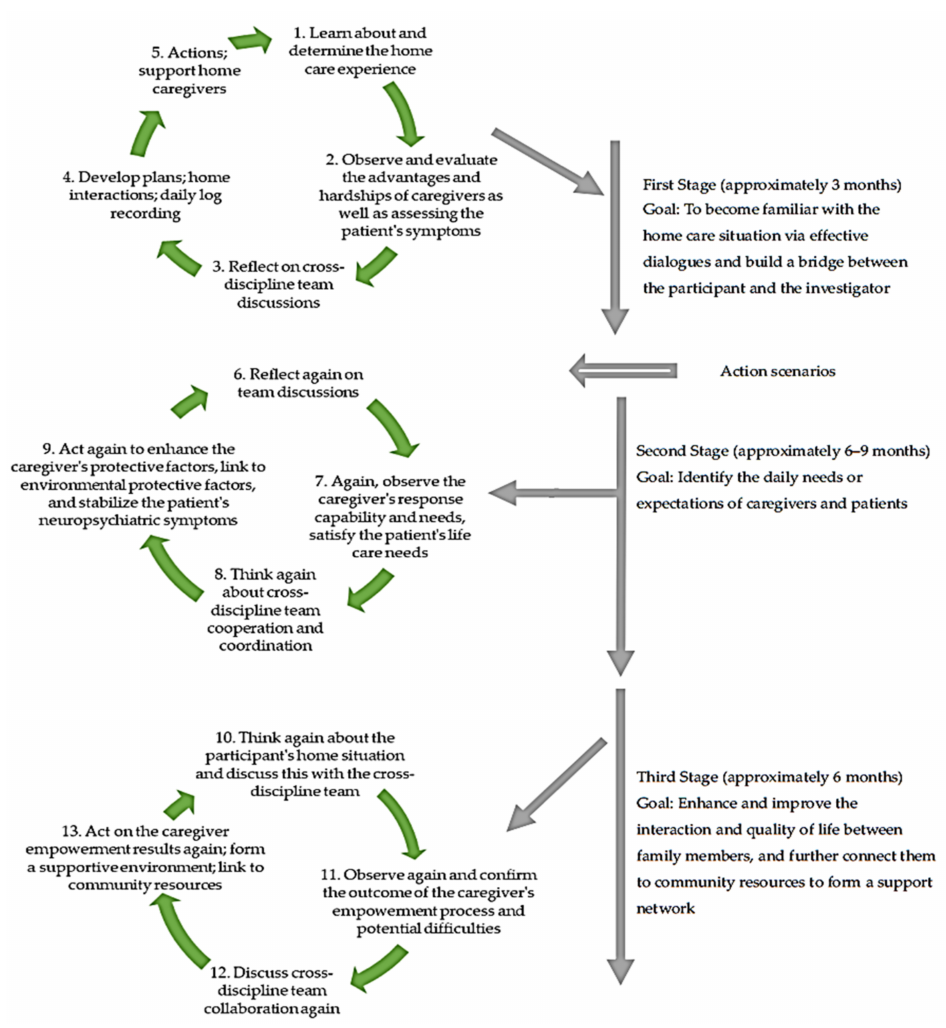
Figure 1. The planning process and goals of action